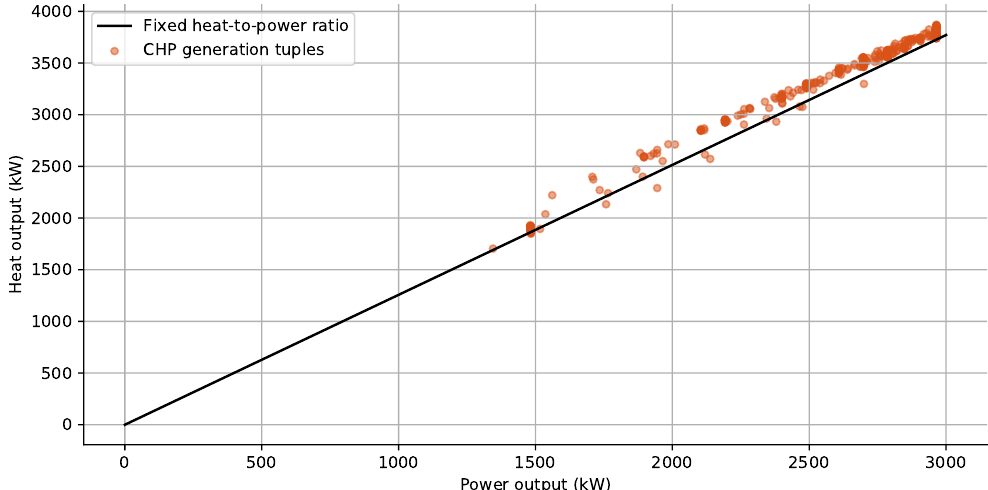
Figure 4. Hourly co-generation tuples in September 2020 and linear heat-to-power ratio from the generators’ data